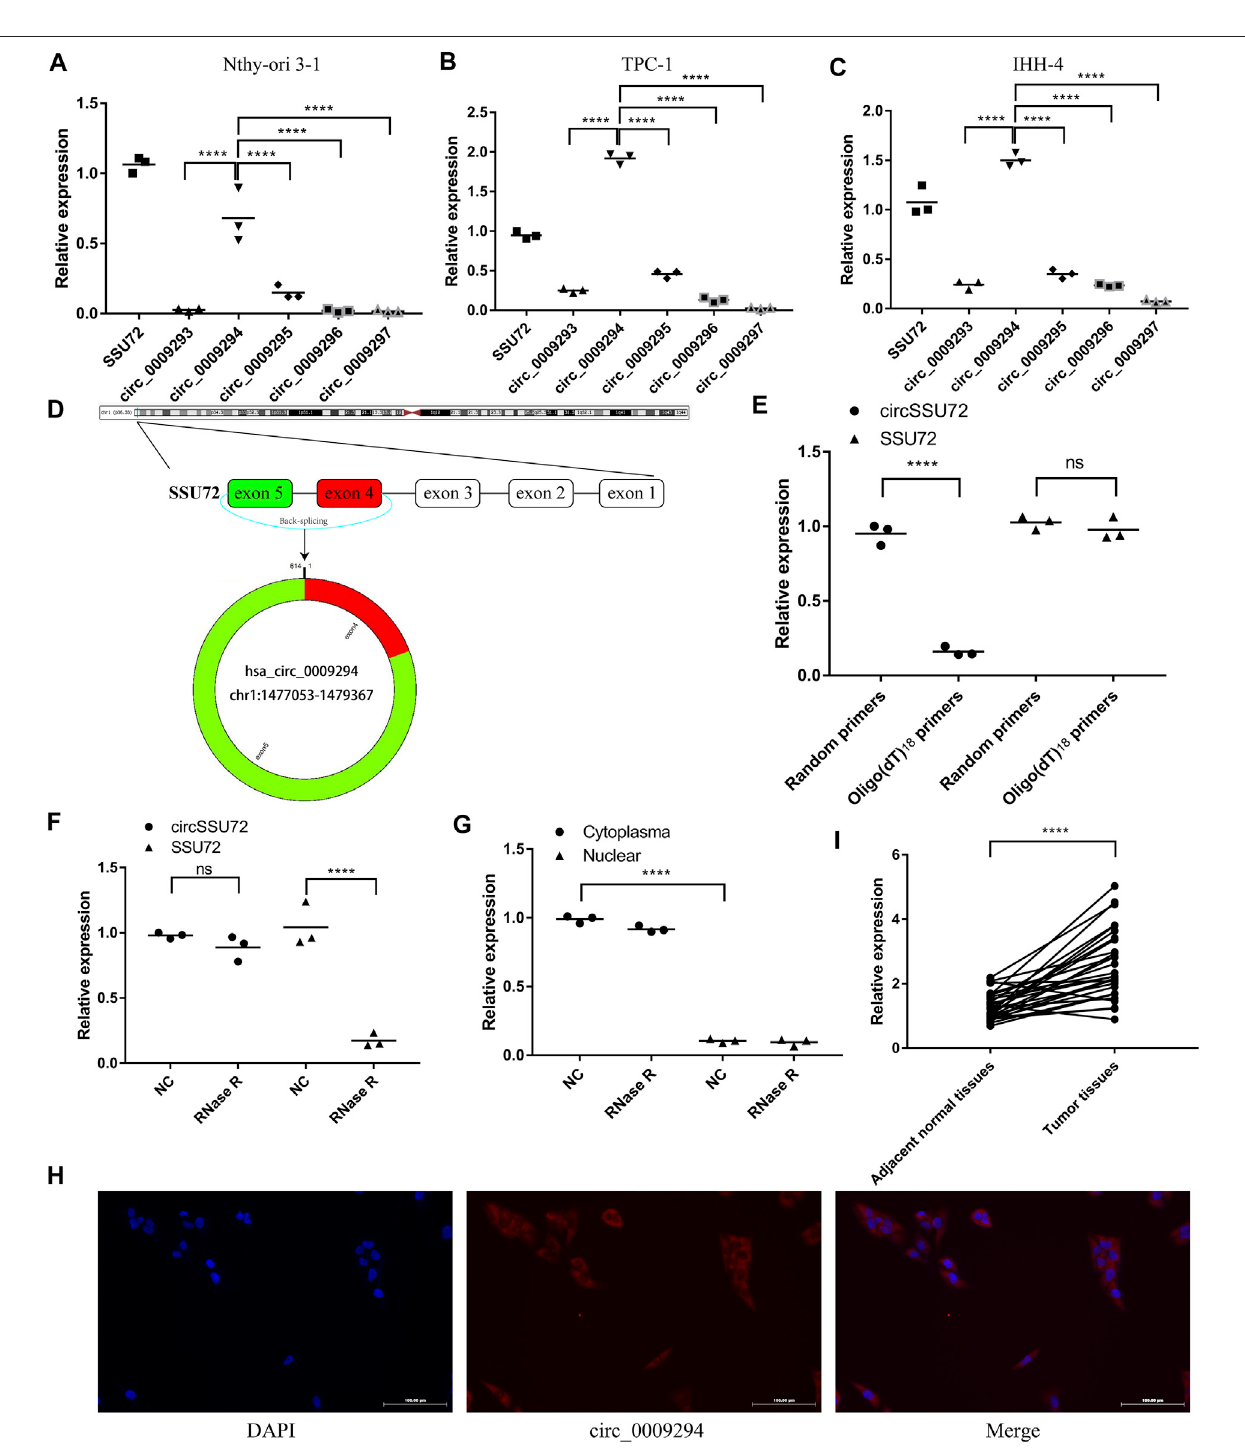
FIGURE 1 | circSSU72 was upregulated in PTC (A) The expression of SSU72-related circRNAs in the Nthy-ori 3-1 cells ( n = 3). (B) The expression of SSU72- related circRNAs in the TPC-1 cells ( n = 3). (C) The expression of SSU72-related circRNAs in the IHH-4 cells ( n = 3). (D) The diagram exhibiting the formation of circSSU72 (hsa_circ_0009294). (E) qRT-PCR detected the levels of circSSU72 and SSU72 mRNA after reverse transcribed with random primers and oligo (dT) 18 primers ( n = 3). (F) The relative expression of circSSU72 and SSU72 mRNA after treatment of RNase R ( n = 3). (G) circSSU72 was separately detected in nuclear and cytoplasm ( n = 3). (H) The expression level of circSSU72 (hsa_circ_0009294) was evaluated by FISH assay in Nthy-ori 3-1 cells. circSSU72 was stained red and nuclei were stained blue using 4 ʹ ,6-diamidino-2-phenylindole (DAPI). Scale bars = 100 µm. (I) The expression of circSSU72 was assessed by qRT-PCR assay in PTC tissues and adjacent normal tissues ( n = 30). * p < 0.05; ** p < 0.01; *** p < 0.001; **** p < 0.0001.